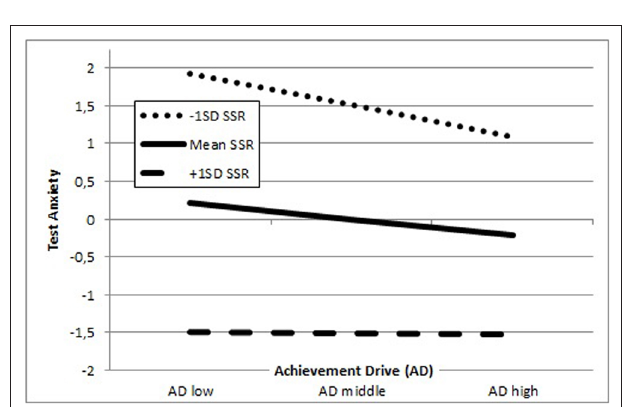
FIGURE 4 | Representation of teacher–student relationships (TSR) as moderator in the association between achievement drive (AD) and test anxiety (TX) among German secondary school students; the Y-axis measures test anxiety and the X-axis indicates achievement